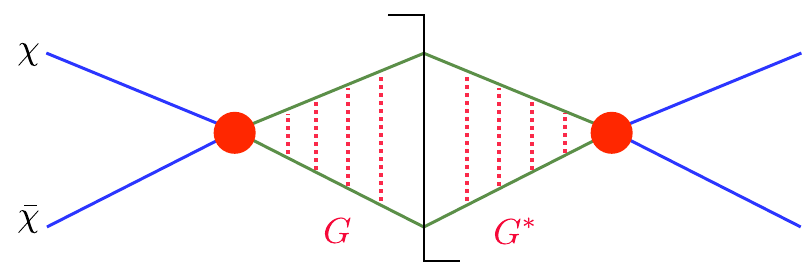
Figure 8 . This (cid:12)gure illustrates Glauber bursts G . For identical gauge index structures, the Glauber contributions to the squared amplitude multiply their conjugates and cancel. In the pres- ence of electroweak charged (cid:12)nal and initial states, di(cid:11)erent gauge index structures are present on either side of the cut. There can then be a miscancellation of the Glauber contributions, leaving behind the residual phase that contributes to our NLL